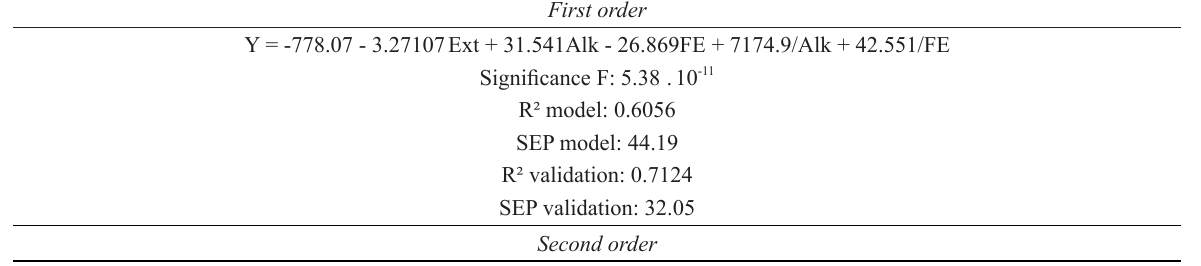
Summary of models obtained by multiple linear